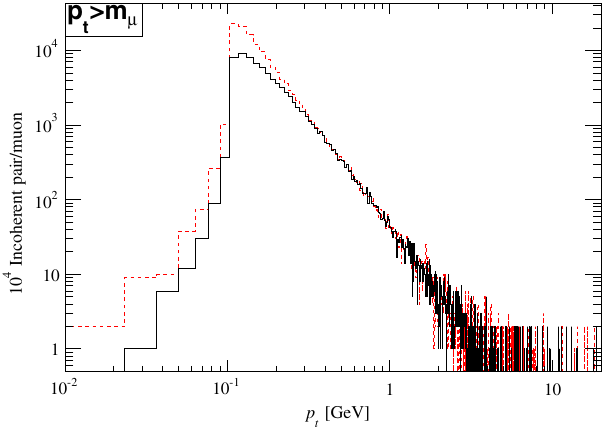
FIG. 18. Comparison of the transverse momentum of incoher- ent electrons and muons. Cross sections have been scaled up by 10 4 to decrease simulation time. At production time, the cut p > m c has been employed. Red dashed line indicates in- t μ coherent electrons. Black solid line indicates incoherent muons.